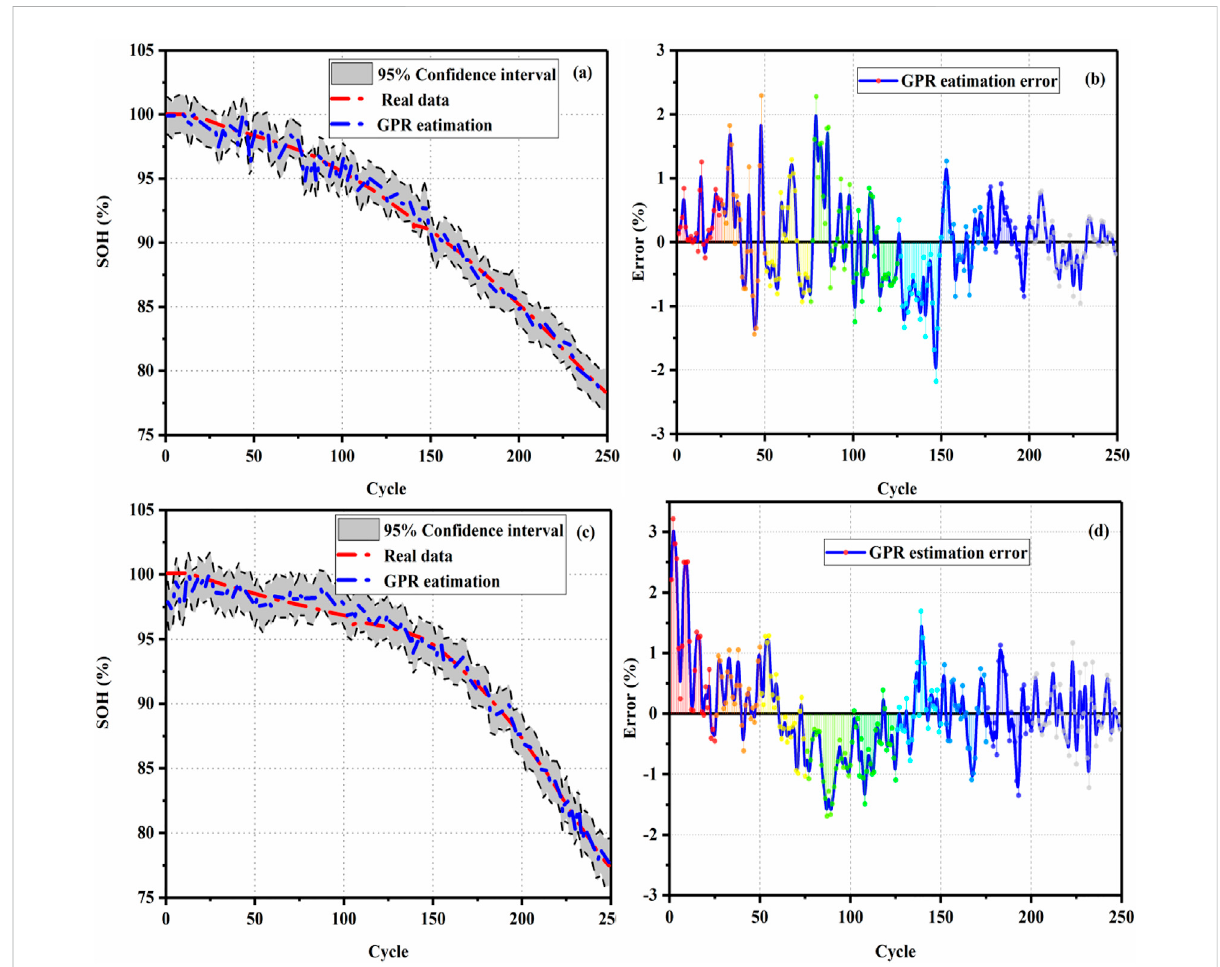
FIGURE 8 (A) SOH estimation under 3.75 V slight overcharge cycling, (B) error under 3.75 V slight overcharge voltage cycling, (C) SOH estimation under 3.80 V slight overcharge voltage cycling, and (D) error under 3.80 V slight overcharge voltage